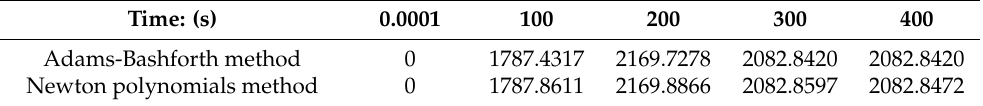
Table 2. Results of the two numerical schemes for the infectious CD4 + T-cells U (s) under the fractal order and fractional order δ = σ = 0.95 with the step size h = 0.1. Time: (s) 0.0001 100 200 300 400 Adams-Bashforth method 0 37.7693 46.0612 44.2611 43.7066 Newton polynomials method 0 37.7778 46.0645 Table 3. Results of the two numerical schemes for free particles of the infection of the HIV virus in the blood V (s) under the fractal order and fractional order δ = σ = 0.95 with the step size h = 0.1. Time: (s) 0.0001 100 200 300 400 Adams-Bashforth method 0 1787.4317 Newton polynomials method